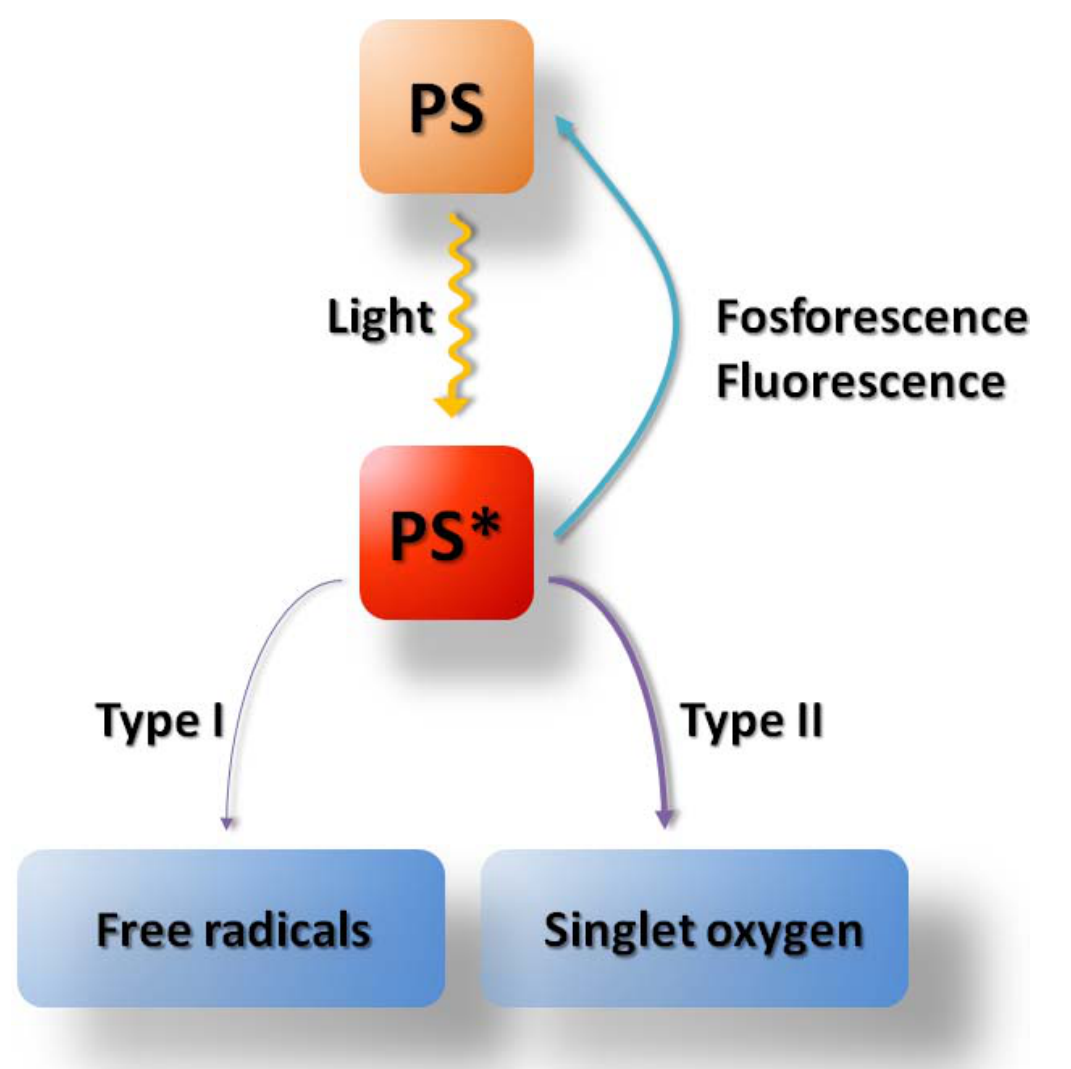
Figure 2. Types of oxidative reactions during PDT. Light with sufficient energy and wavelength matching absorption spectrum of the photosensitizer (PS) can activate a photochemical reaction that leads to formation of activated PS molecule (denoted by asterisk). Activated PS can lose its energy by emitting of visible light (fosforescence or fluorescence). Alternatively it may generate singlet oxygen in a type II reaction or free radicals in a type I